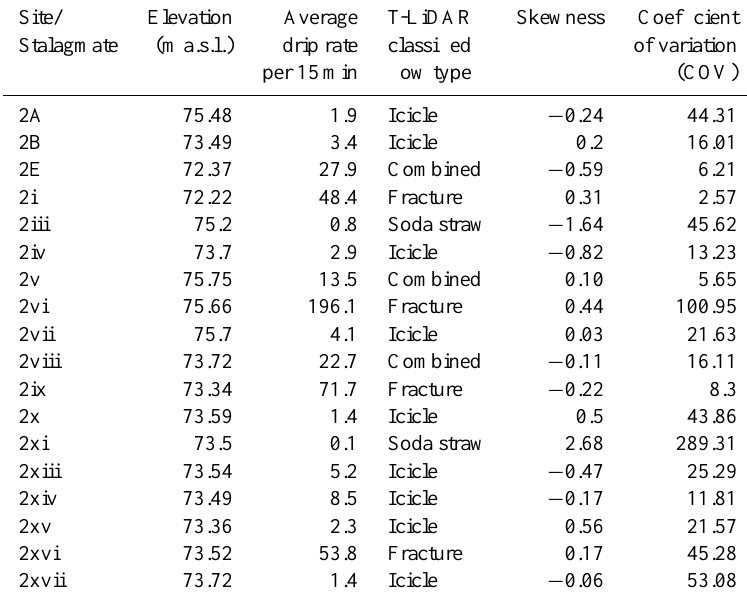
Table 2. Flow classification of chamber 2 drip